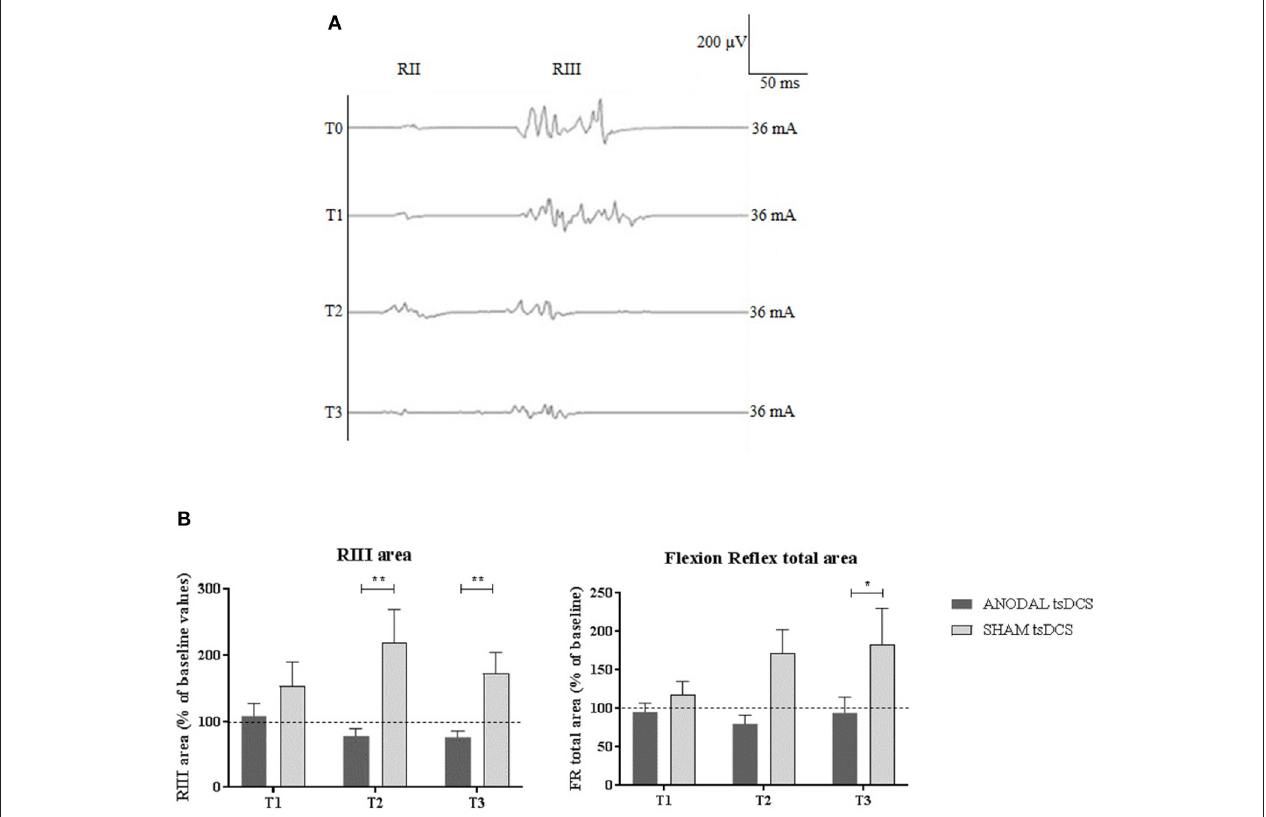
FIGURE 2 | LLFR changes. (A) Exemplificative averaged traces of RIII reflex recorded before (T0), at the end of 5 days treatment (T1), and 1 week (T2) and 1 month (T3) after the completion of anodal tsDCS protocol. (B) Changes in RIII area and FR total area between anodal (black bars) and sham (gray bars) conditions. Data are given as normalized to T0 mean ± SE. The statistical significance refers to the comparison between anodal (active) and sham (placebo) stimulation (* p < 0.05; ** p < 0.001, Wilcoxon’s test post-hoc analysis).